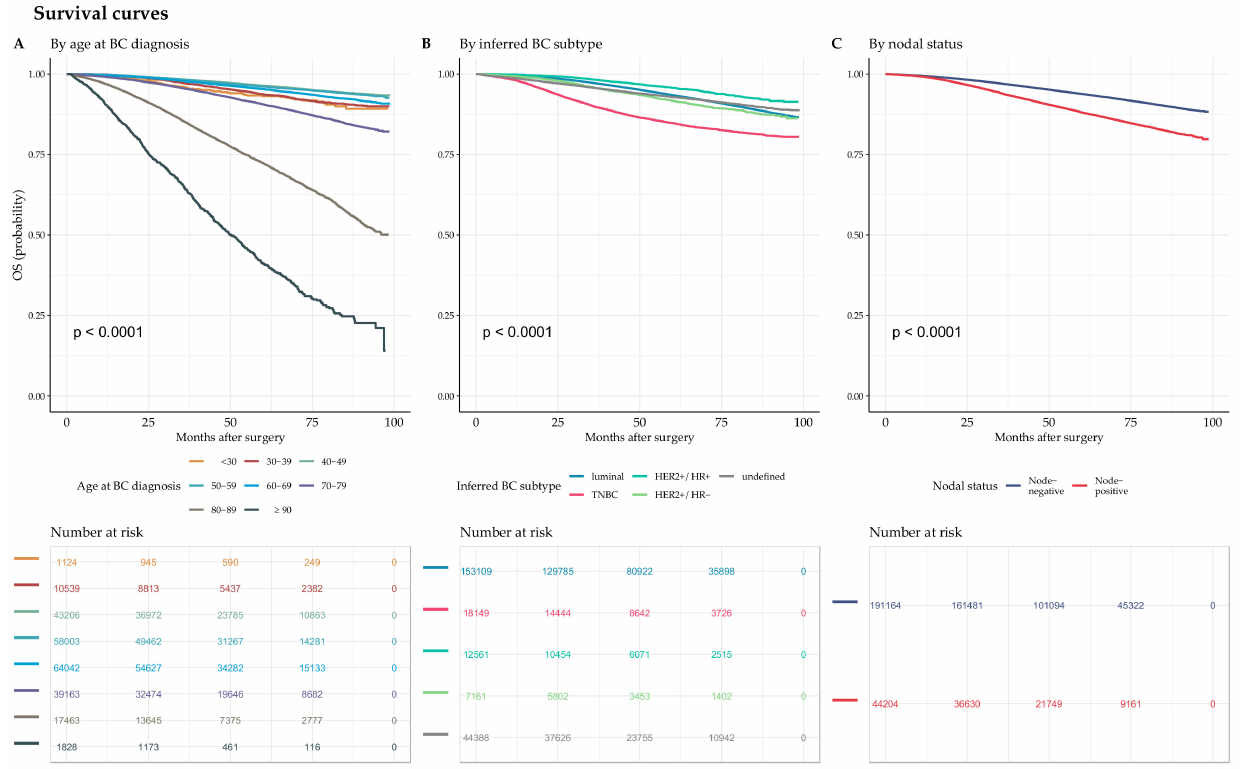
Figure 5. Unadjusted Kaplan-Meier survival curves. ( A ) Unadjusted Kaplan-Meier survival curves for the association between overall survival (OS) and age class at BC diagnosis. ( B ) Unadjusted Kaplan- Meier survival curves for the association between OS and inferred BC subtype. ( C ) Unadjusted Kaplan-Meier survival curves for the association between OS and nodal